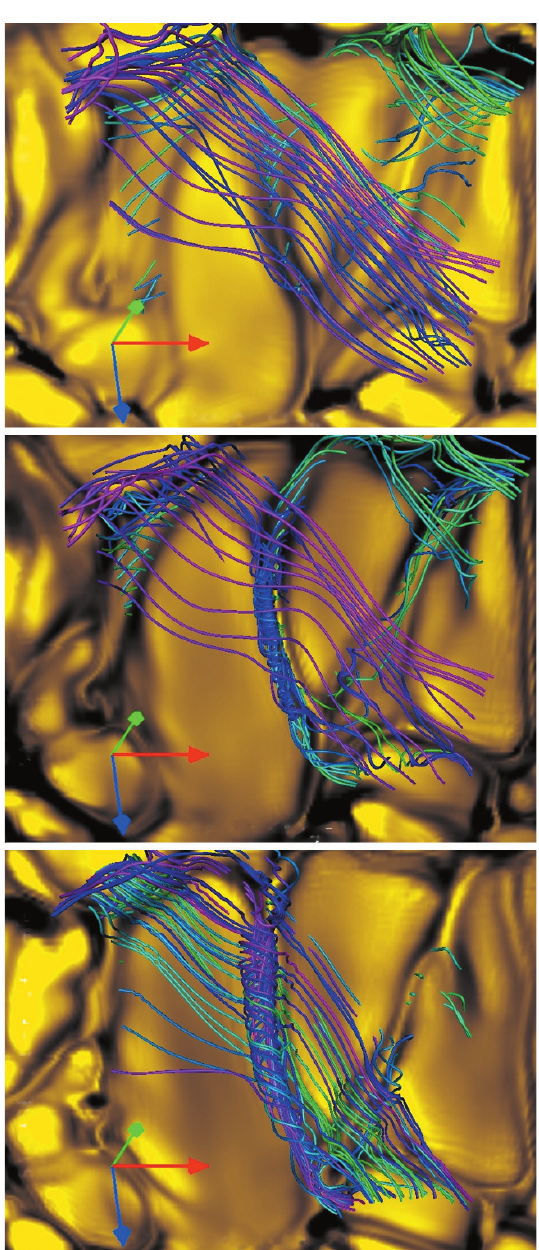
Figure 29: 3D visualization of the creation of small-scale twisted magnetic flux tube at an intergran- ular lane immediately below the photosphere (from Tortosa-Andreu and Moreno-Insertis, 2009). Images with yellow color-coding show the distribution of vertical velocity at constant geometrical height in the photosphere. Image reproduced with permission, copyright by